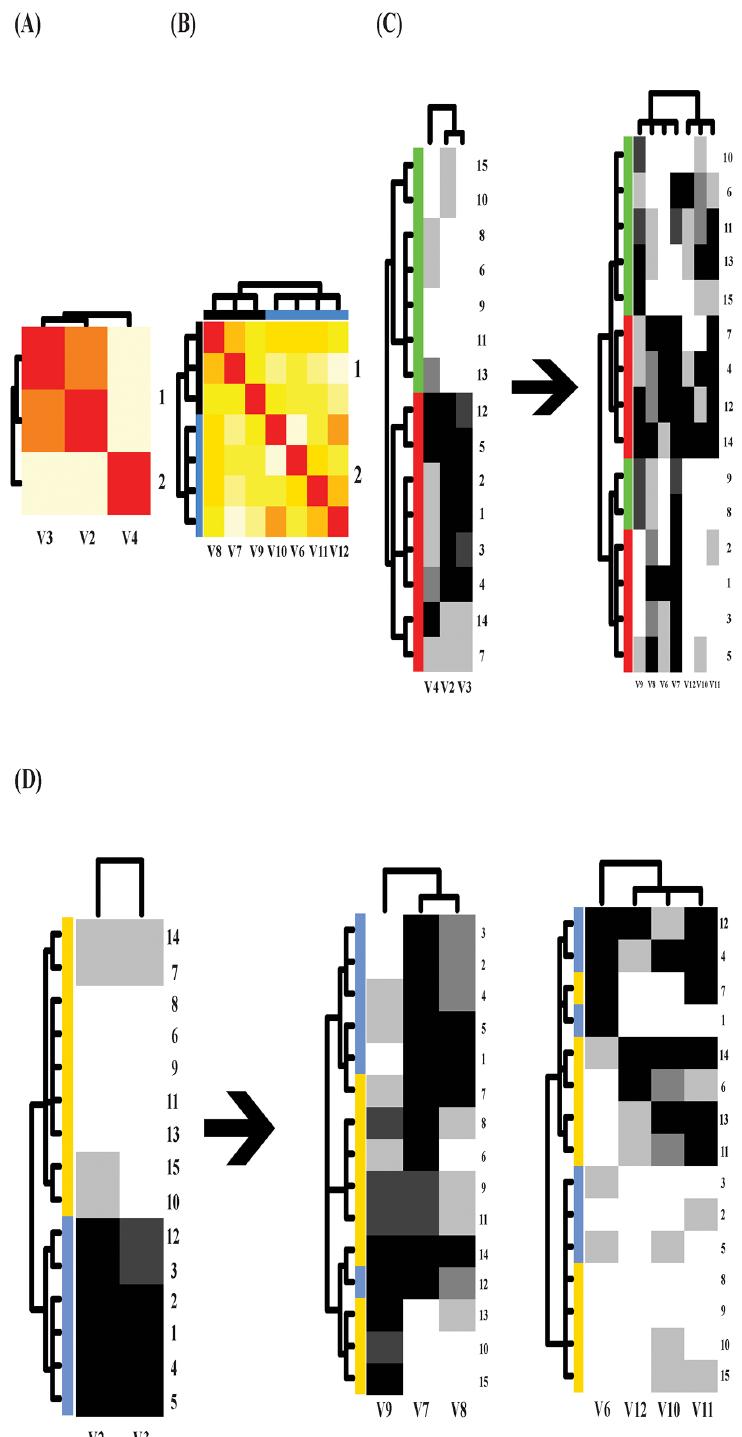
Fig 7. Mutual conditional entropy matrices and two information flows on bird data. (A) Mutual conditional entropy matrix of 3 response features divided into two synergistic groups; (B) 7 × 7 mutual conditional entropy matrix of covariate features with two color-coded synergistic groups; (C) Information flow from the response heatmap to the covariate heatmap showing heterogeneity; (D) Information flow from two response features v2 and V3 to two covariate heatmaps pertaining to the two synergistic